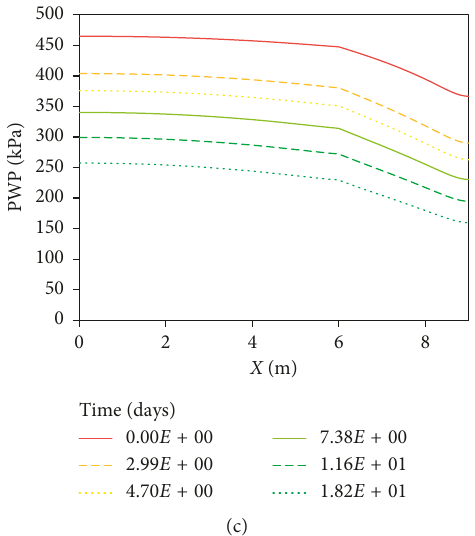
th (last) backfill